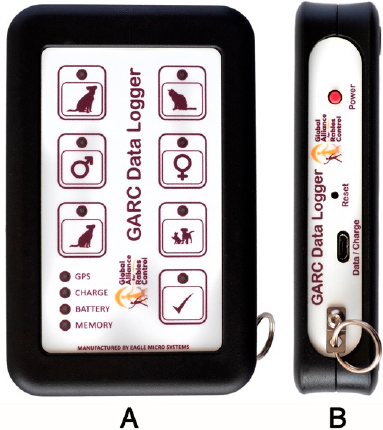
Figure 1. The front ( A ) and side ( B ) view of the Global Alliance for Rabies Control (GARC) Data Logger (GDL). Each picture on the front of the GDL device is a touch-activated button that has a corresponding LED that lights up when selected.